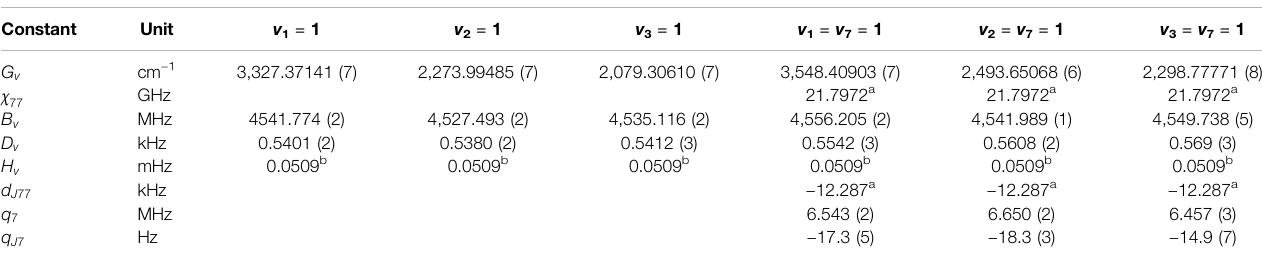
TABLE 3 | Spectroscopic constants determined for HC 3